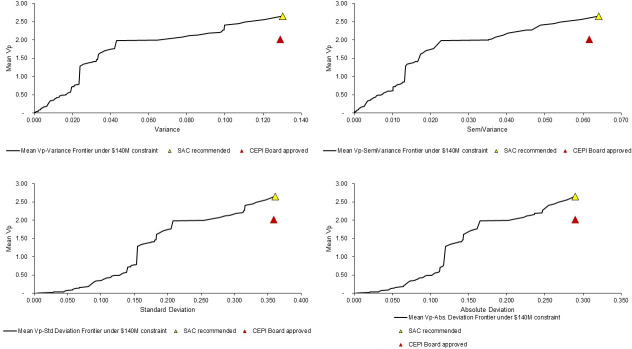
Optimal frontiers by mean-variance, mean-semivariance, mean-standard deviation, and mean-absolute deviation, under a US$140 million constraint.